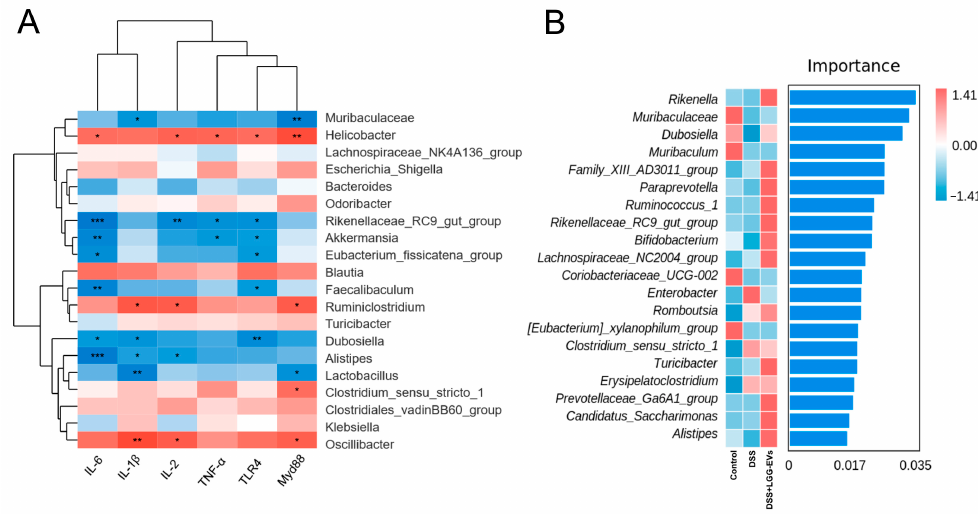
Figure 6. Relative abundance of KEGG pathways. Metabolism pathways of gut microbiome were predicted to show significantly different abundances in the DSS vs. Control group ( A ) and LGG-EVs vs. DSS group ( B ) according to the Kyoto Encyclopedia of Genes and Genome (KEGG) pathway analysis. ( n = 5).